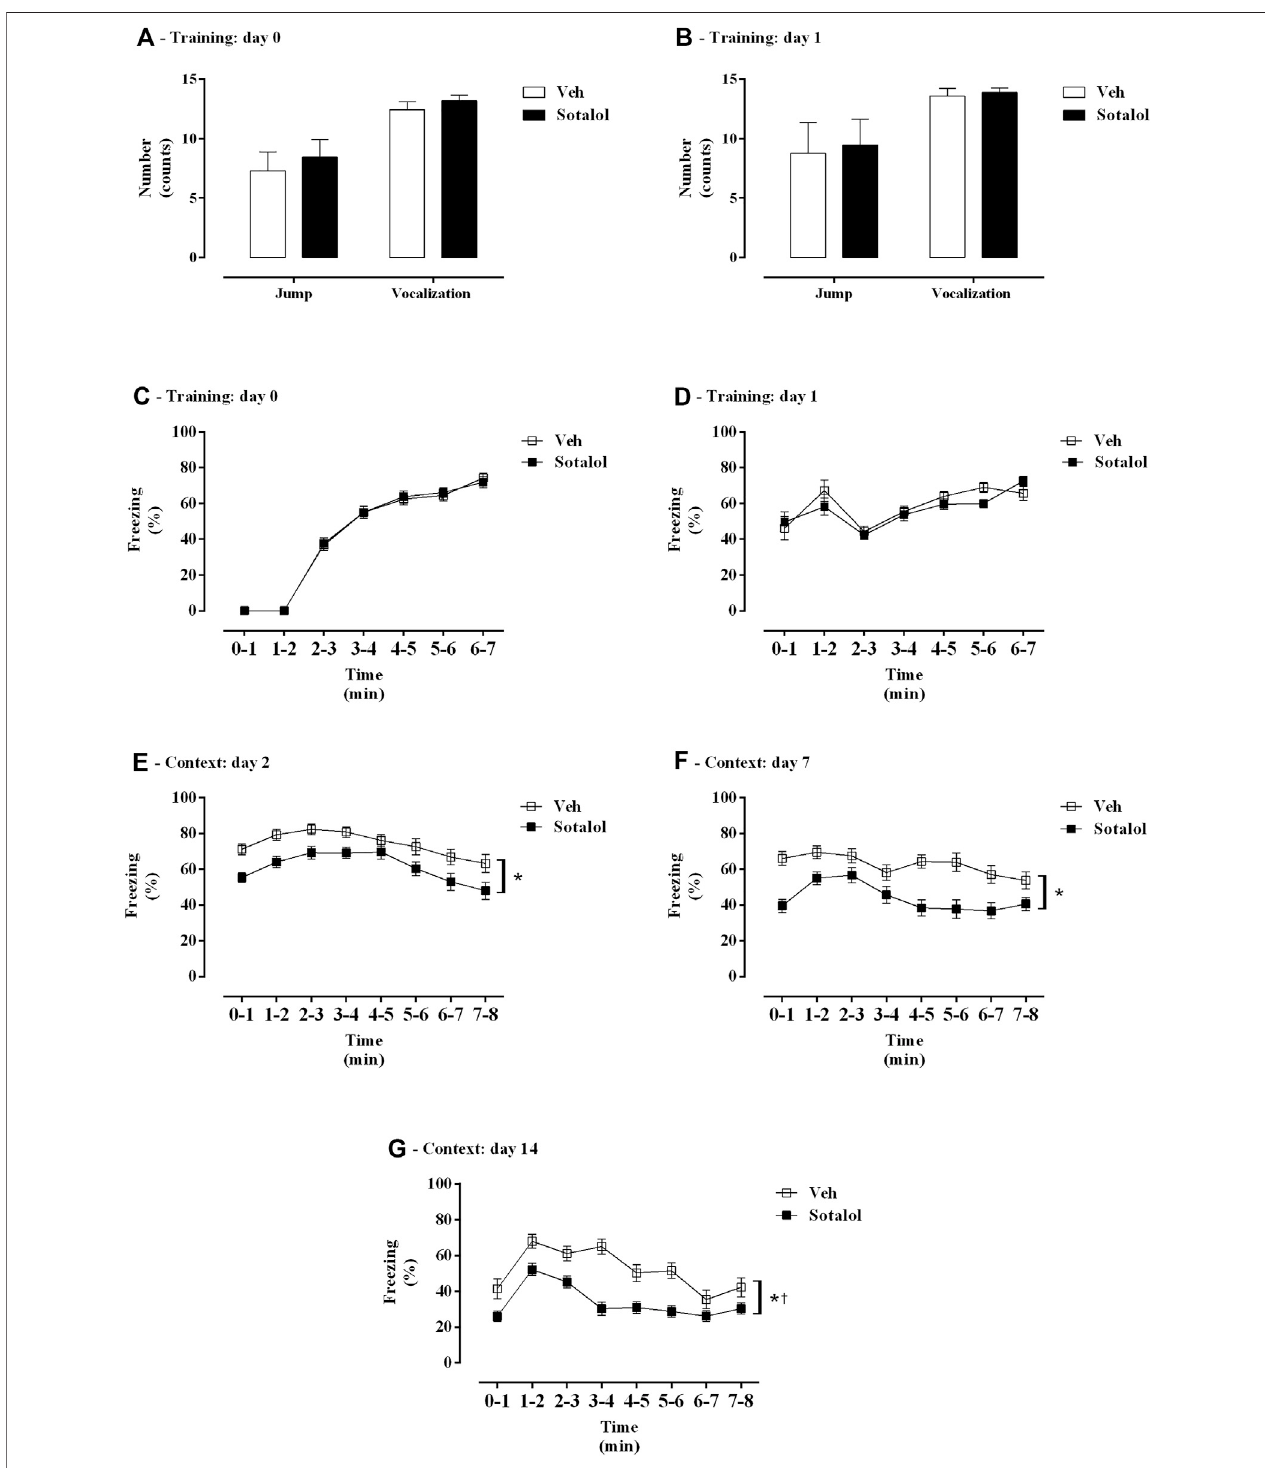
FIGURE 2 |(A, B) Shock responsivity and (C – G) freezing behavior during induction of post-traumatic stress disorder (PTSD) on (A, C) day 0, (B, D) day 1, (E) day 2, (F) day 7, and (G) day 14. Veh, vehicle-treated PTSD mice; Sotalol, sotalol-treated PTSD mice. Values are means ± SEM of 13 mice per group. *, treatment and time effect with two-way repeated measures ANOVA ( p < 0.05). † , interaction with two-way repeated measures ANOVA ( p < 0.05).